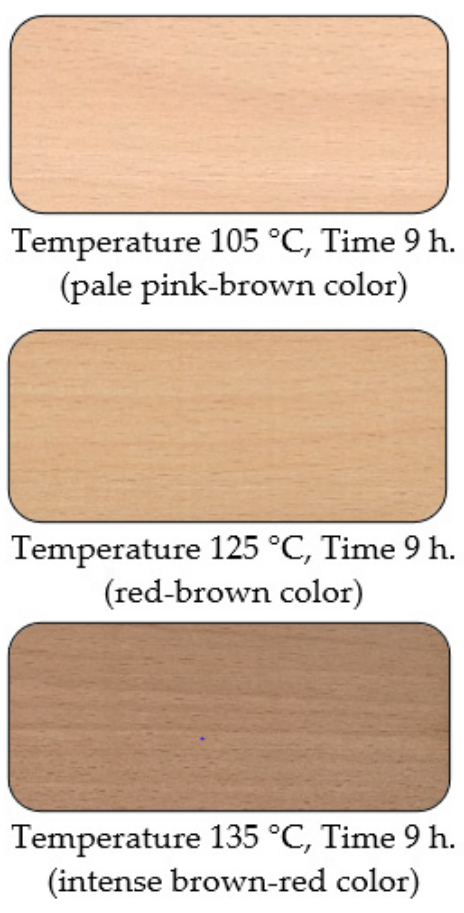
Figure 3. Color change of beech wood after steaming. Note: Reproduces from Dzurenda, L. Colouring of beech wood during thermal treatment using saturated water steams; published by Acta Fac. Xylologiae Zvolen, 2014, with permission from Acta Fac. Xylologiae Zvolen, 2022.